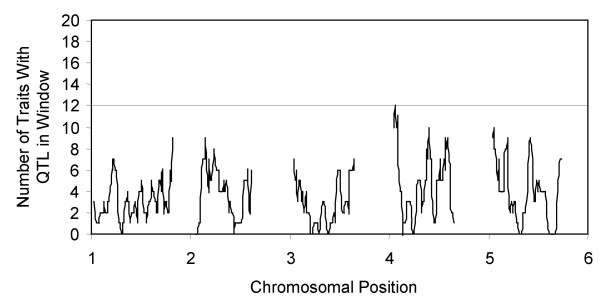
Summation approach to phenotype QTL clustering. The number of physiological traits showing a QTL within a 5 cM sliding window is shown. One thousand permutations of this data showed that the P = 0.05 threshold for significant enhancement is 12 traits with a QTL per sliding window (horizontal line). QTLs for 62 phenotypic traits were used for this analysis. The five chromosomes begin at the corresponding number such that 1 is the start of chromosome I, etc.